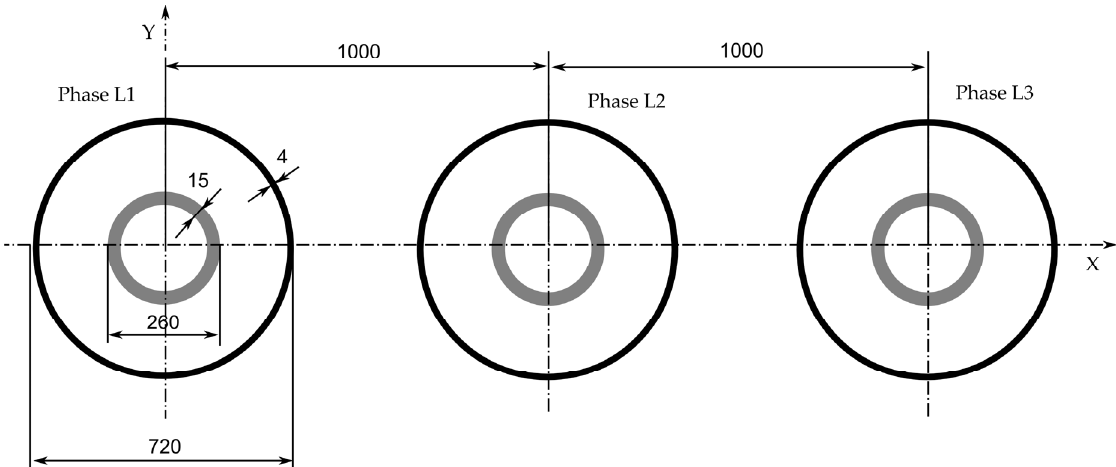
Figure 3. Graphical depiction of the cross-section geometry of the high-current busduct under